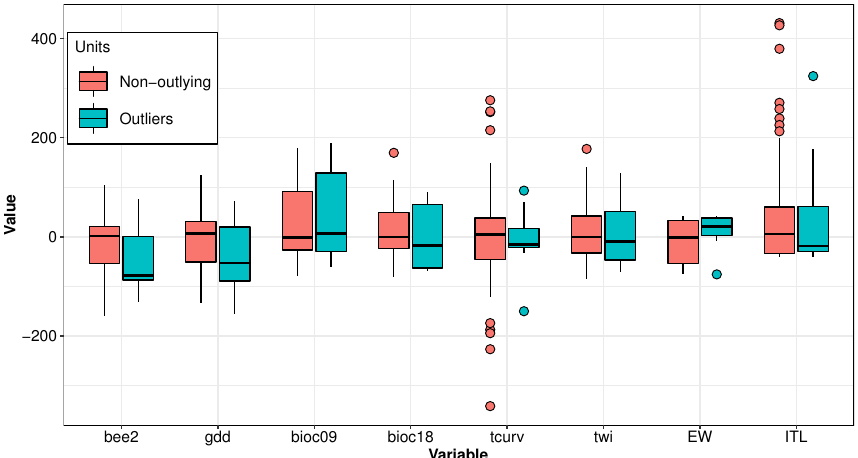
Figure 4. Box plots comparing the values assumed by the features selected by MIProb contrasting outlying and non-outlying case. The values of each feature are scaled to have zero median and MAD equal to the average MAD across